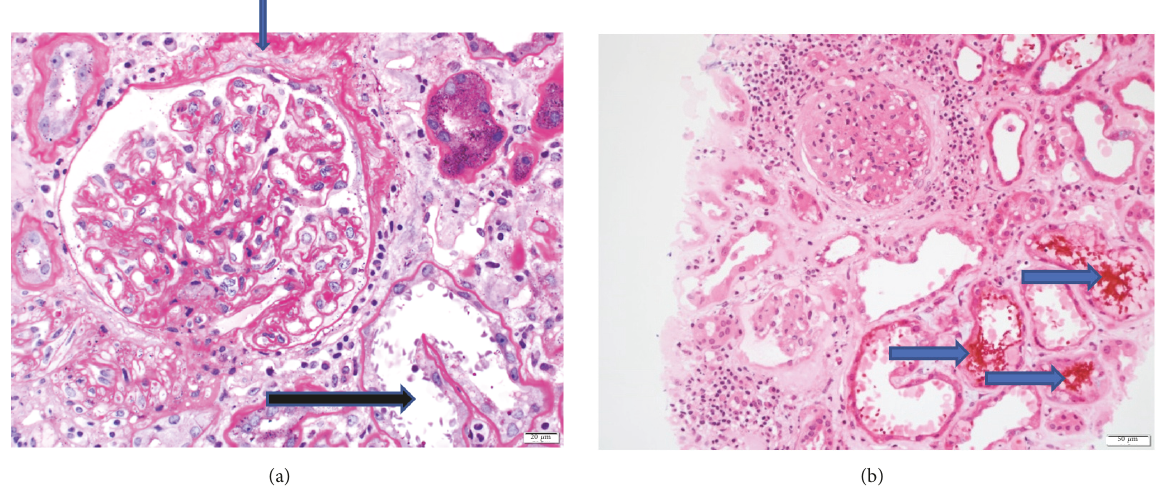
Figure 3: Kidney biopsy histopathology II. (a) Periodic Acid Schiff (Magnification: X200) staining of glomeruli shows minimal mesangial expansion with no evidence of mesangial and endocapillary proliferation. Chronic ischemic damage is also evident by thickening of Bowman capsule membrane (blue arrow). The damaged tubules (black arrow) are also shown. (Light Microscopy.) (b) Hematoxylin and Eosin staining (Magnification: X100) shows damaged tubules with RBC casts (arrows) being seen. There is an absence of active glomerulonephritis.